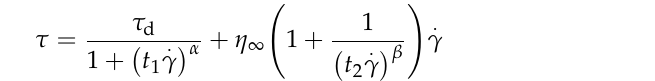
Figure 9. Flow curves of shear stress–shear rate of ER fluids under DC electric field. ( a ) graphene/PANI and ( b ) PANI [83]; ( c ) rGO/PPy and ( d )pure granular PPy [84].